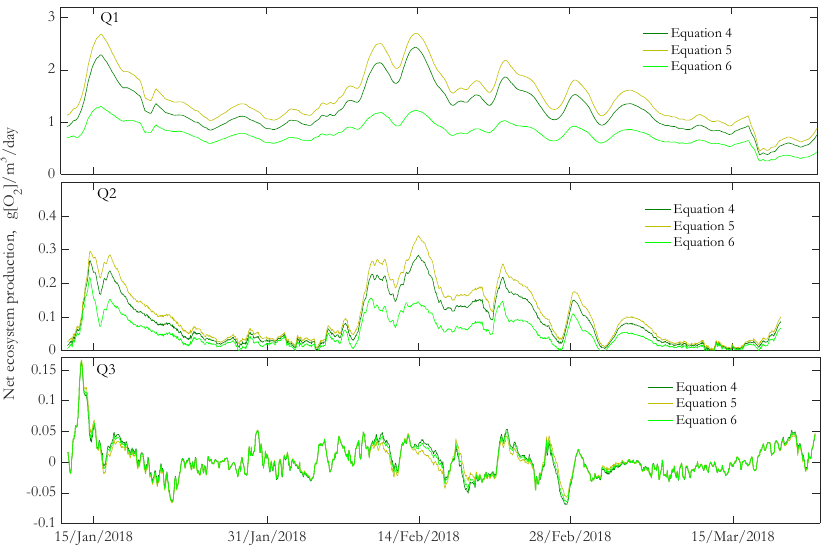
Figure 9. Comparison of the net ecosystem production using Equations (4)–(6) to estimate reaeration rates k at Q1, Q2 and Q3 locations along the Kanawha River, from 11 January 2018 to 22 March 2018.